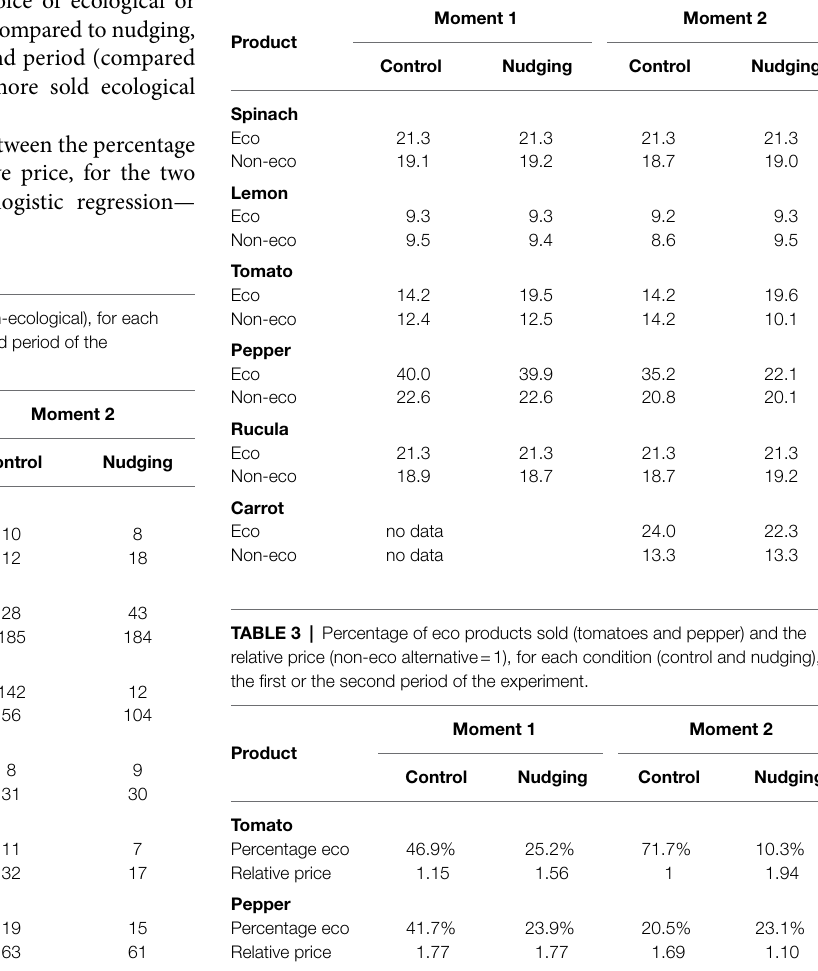
TABLE 2 | Mean price of sold products (ecological or non-ecological, in swedish crowns), for each condition (control and nudging), in the first or the second period of the experiment.